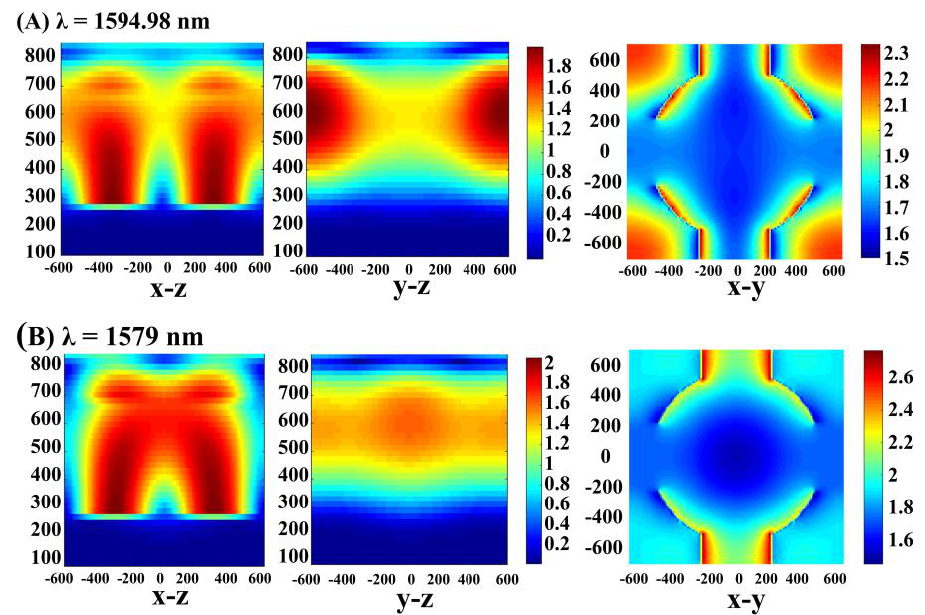
Figure 5. ( A ) Section view of a side electric field under a critical coupling state and the x - y plane electric field diagram (wavelength: 1594.98 nm). ( B ) Sectional view of a side electric field and the x - y plane electric field diagram in a non-critical coupling state (wavelength: 1579 nm).